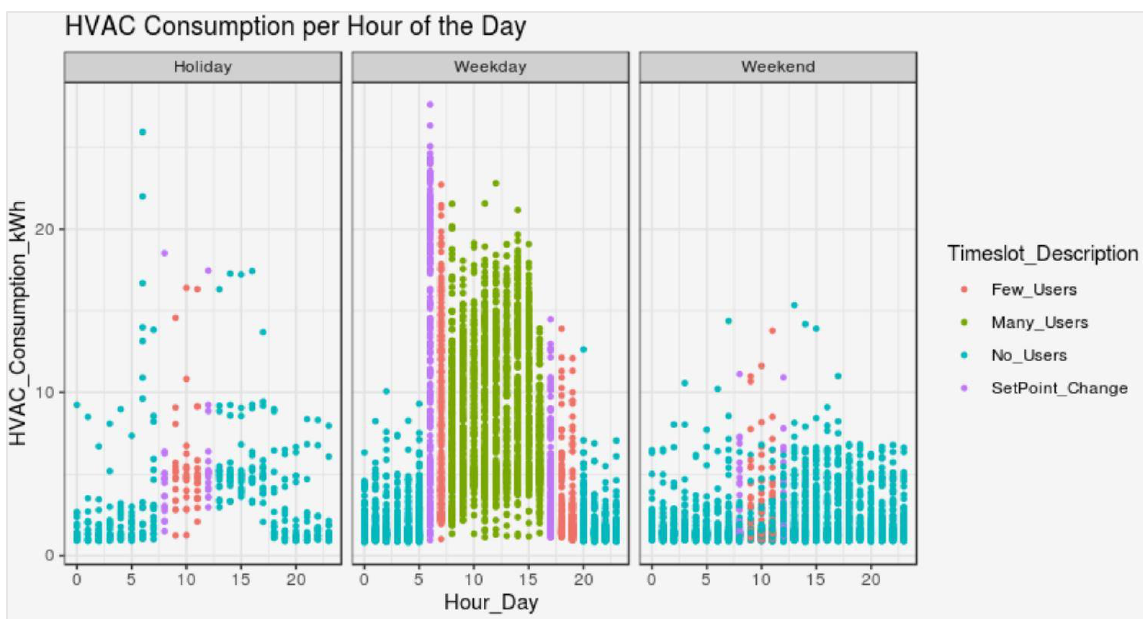
Figure 7. HVAC consumption per hour of the day .